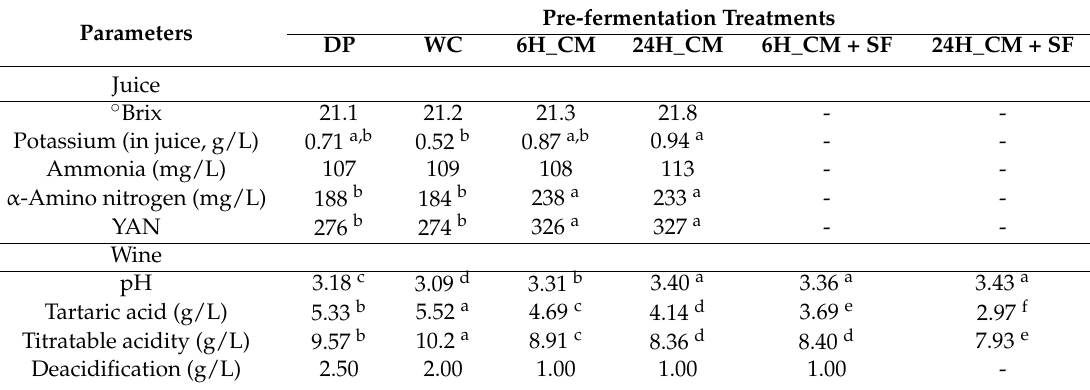
Table 2. Chemical parameters of “Solaris” juice and young wines after completing of fermentation and levels of deacidification with calcium carbonate.